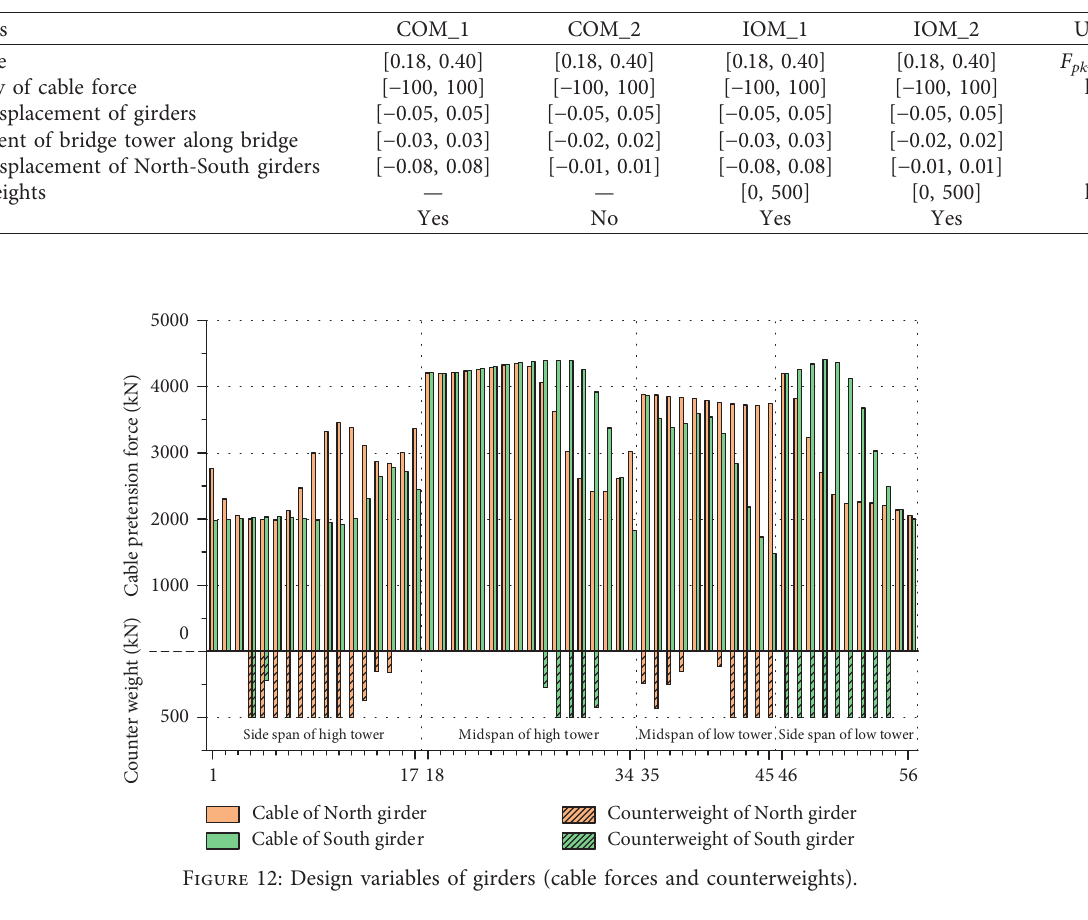
Table 2: Range of constraint conditions.